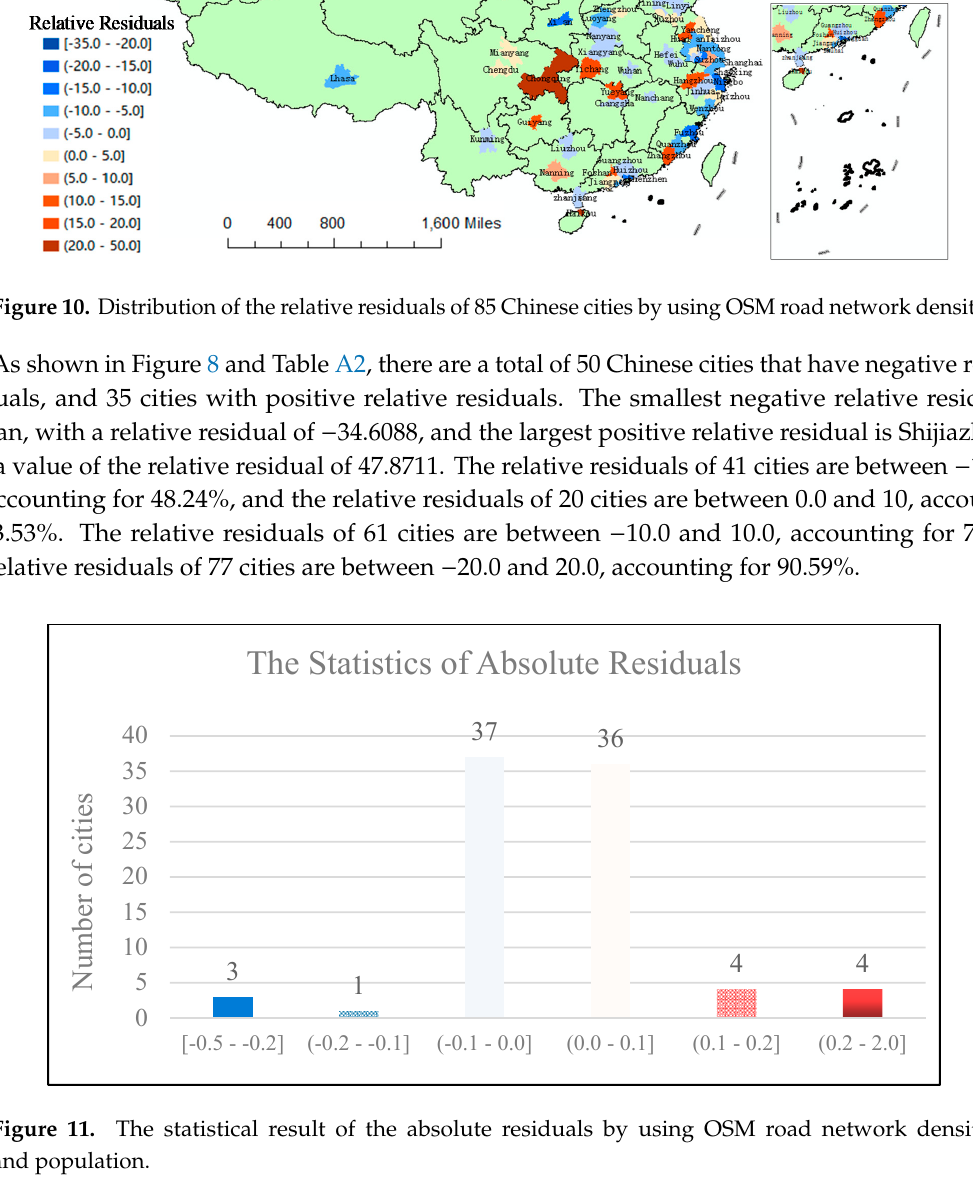
Figure 12. The statistical result of the relative residuals by using OSM road network density and population.